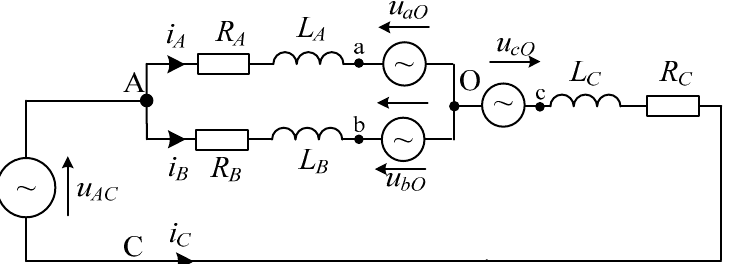
Figure 2. Equivalent simplified circuit diagram of the proposed testing system.